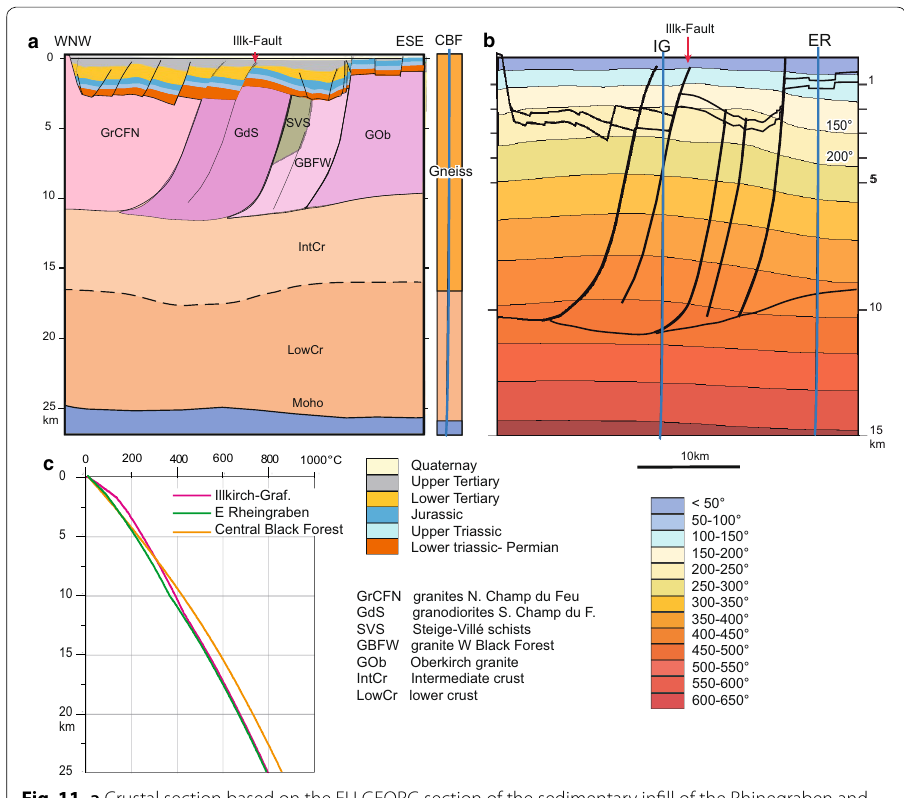
Fig. 11 a Crustal section based on the EU GEORG section of the sedimentary infill of the Rhinegraben and on the ECORS_DEKORP seismic section down to the Moho (Brun et al. 1991; Edel and Schulmann 2009). The NW–SSE profile passes through the Illkirch area. b Temperature model using the adjacent section and the petrophysical parameters of Table 1. The objectives being in the upper crust., the vertical scale has been magnified. The upper and lower boundaries of the Lower Triassic–Permian and the main faults are superimposed with the section. c Log of temperatures in the Illkirch project area (IG), the easternmost Rhinegraben (ER) and the Central Black Forest (CBF) ( b